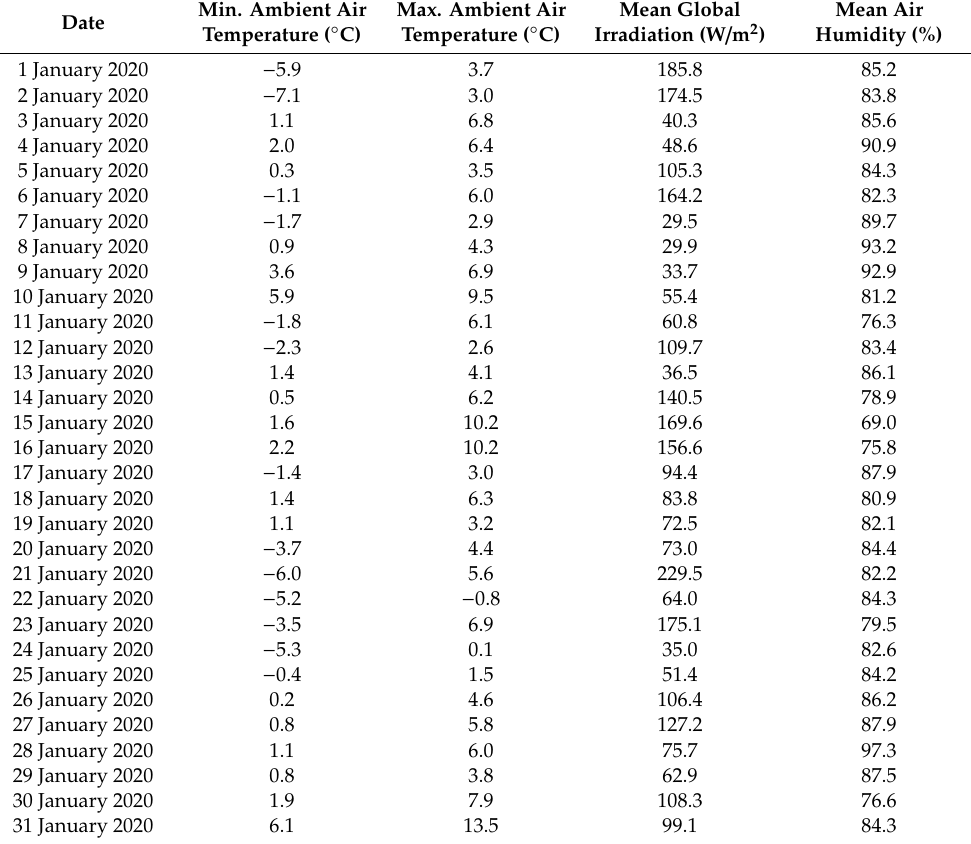
Table A2. Measured boundary conditions in January